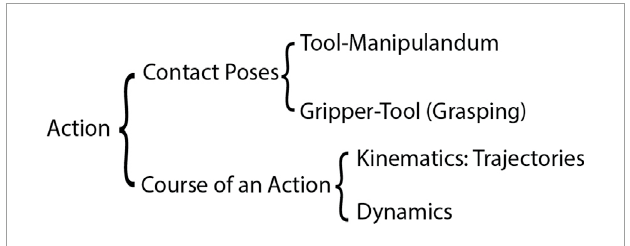
FIGURE 1 Components of an action. The diagram is adapted from Qin et al. (2021), CC